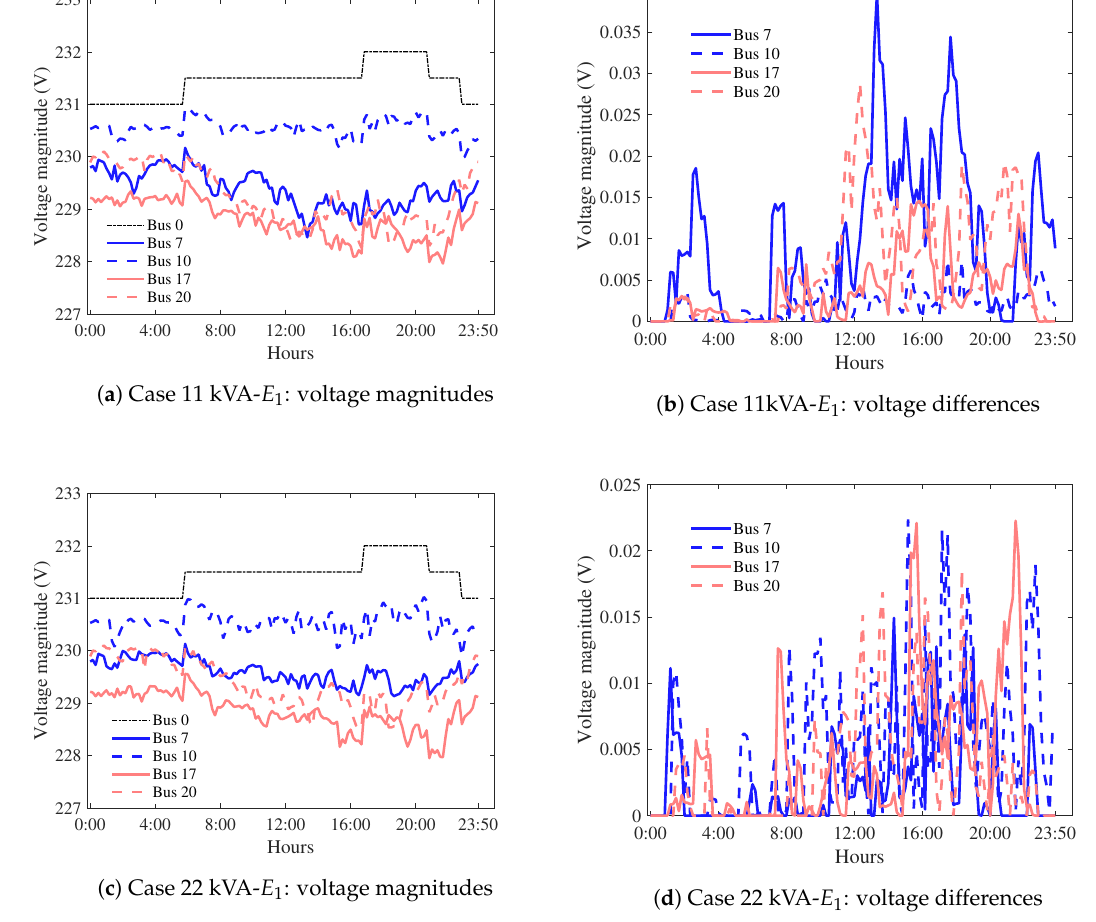
Figure 11. Case study: comparison of voltage magnitudes